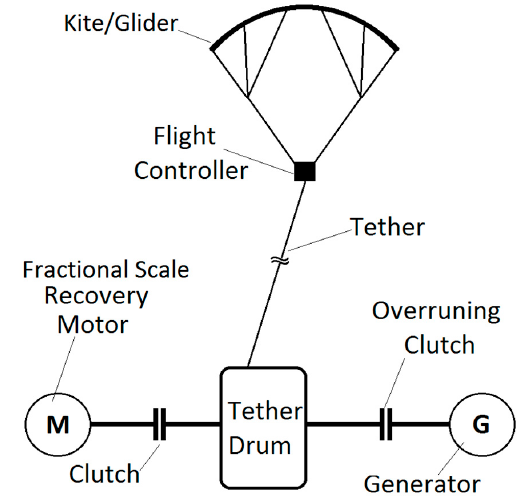
Figure 1. Simplified schematic of a direct drive non-reversing pumping-mode airborne wind energy system.